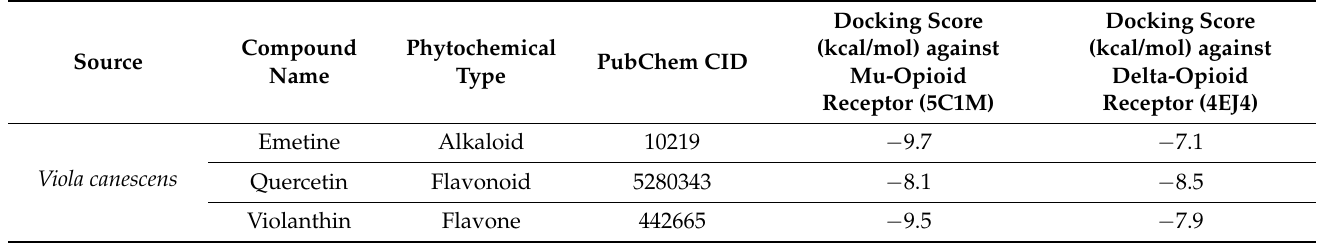
Table 3. The docking scores of compounds against mu and delta-opioid receptors ( µ OR and δ OR).